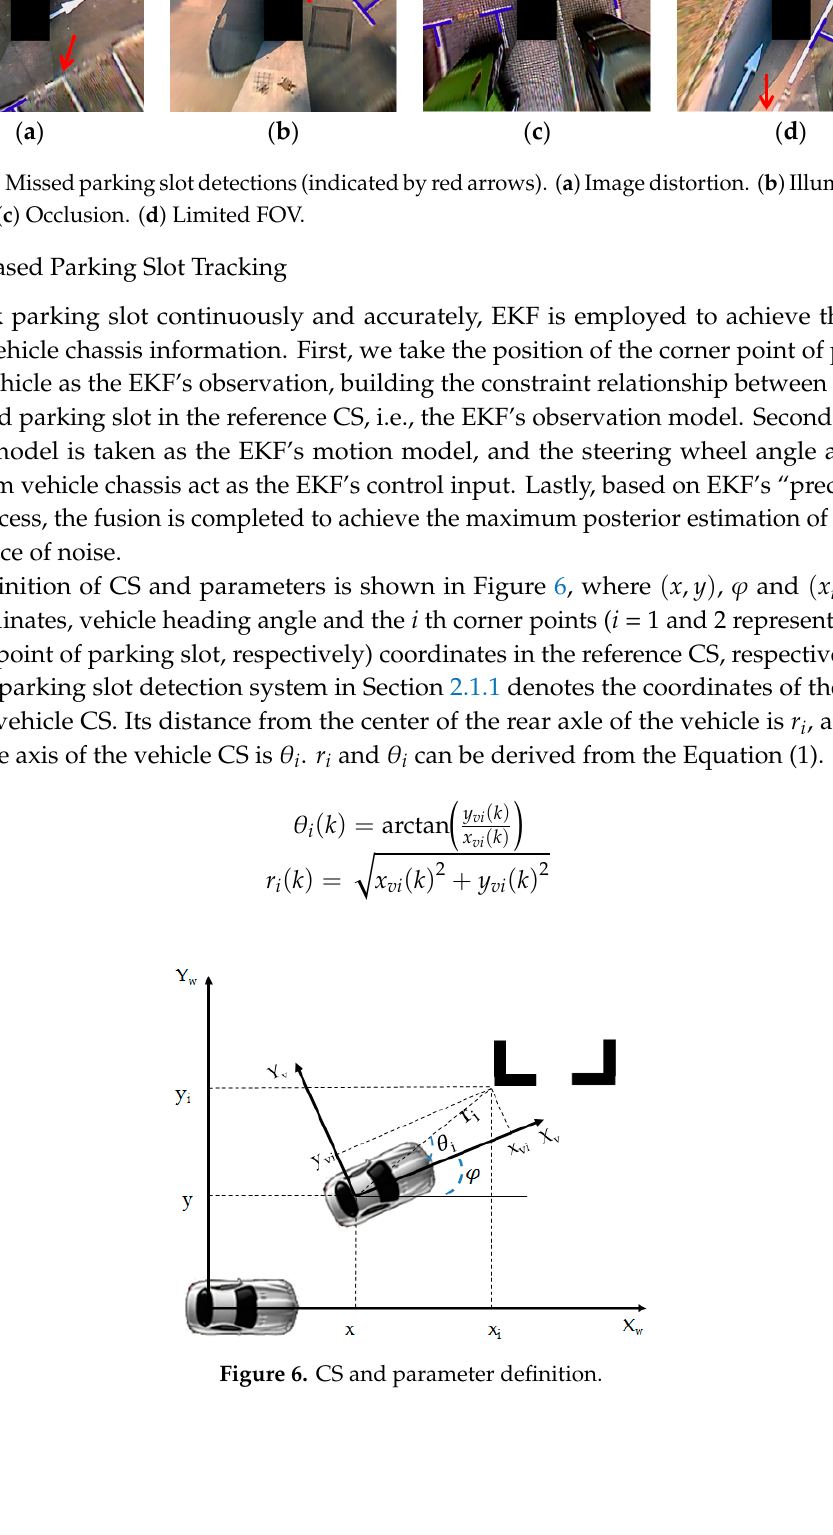
Figure 6. CS and parameter definition.